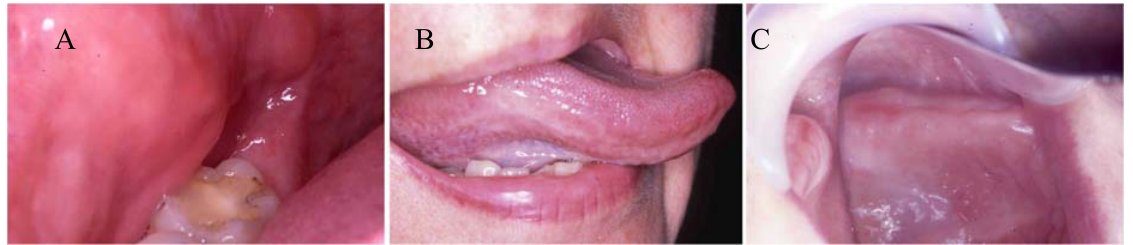
Figure 2. Clinical cases of adverse reactions to resin-based dental materials: (A) Oral lichenoid reaction to an occlusal composite restoration on the buccal mucosa; (B) Oral lichenoid reaction to a lingual composite restoration on the lateral border of tongue; and (C) allergic reaction to denture base material on the alveolar ridge and hard